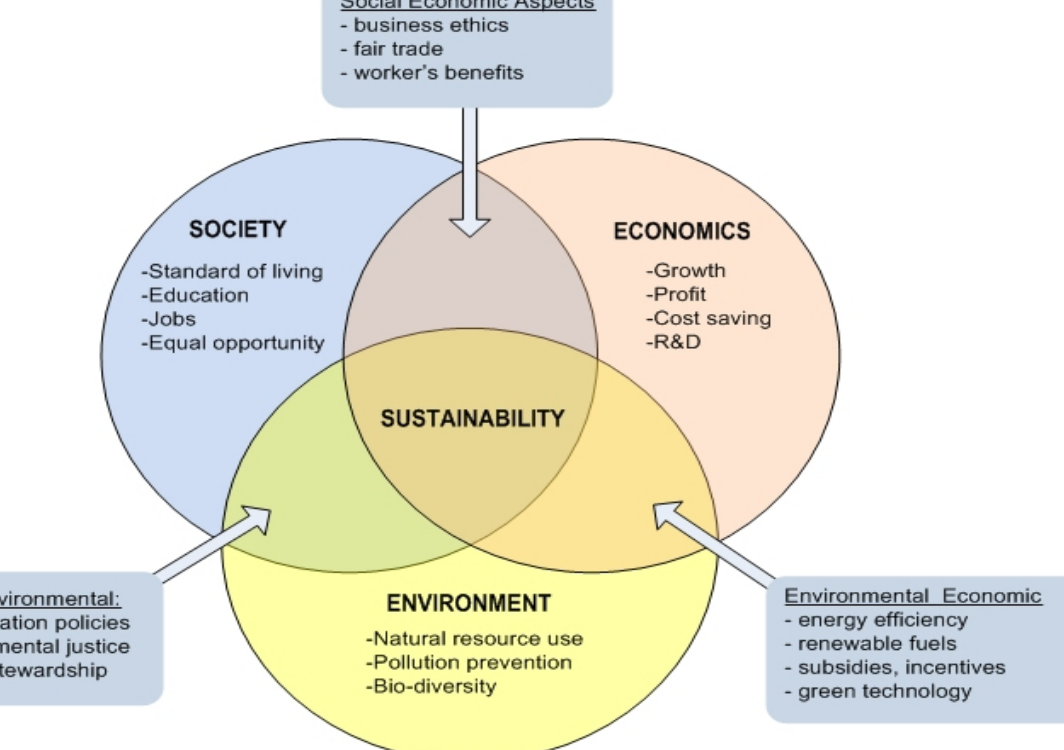
Figure 2. Interplay of the environmental, economic, and social aspects of sustainable development (Mark Fedkin [23]; adopted from the University of Michigan Sustainability Assessment [56]).